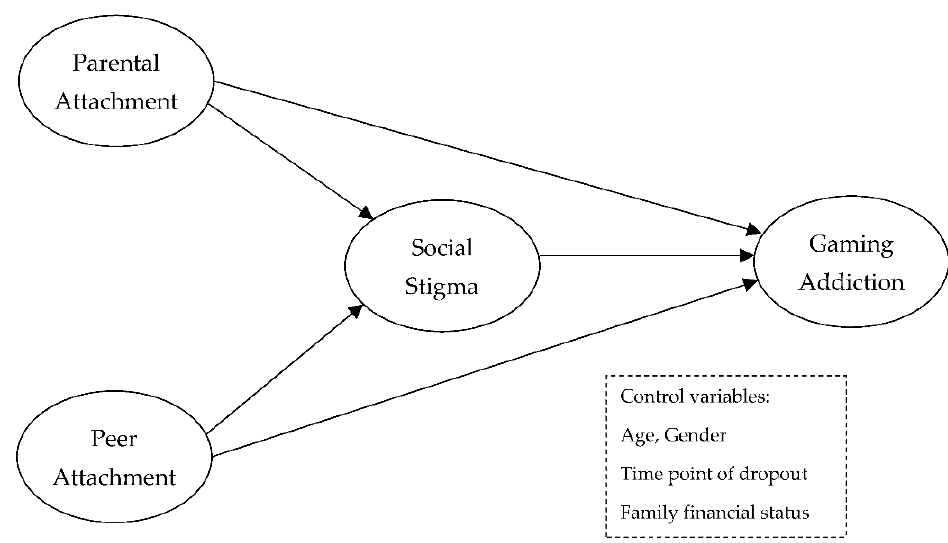
Figure 1. Hypothesized conceptual model.